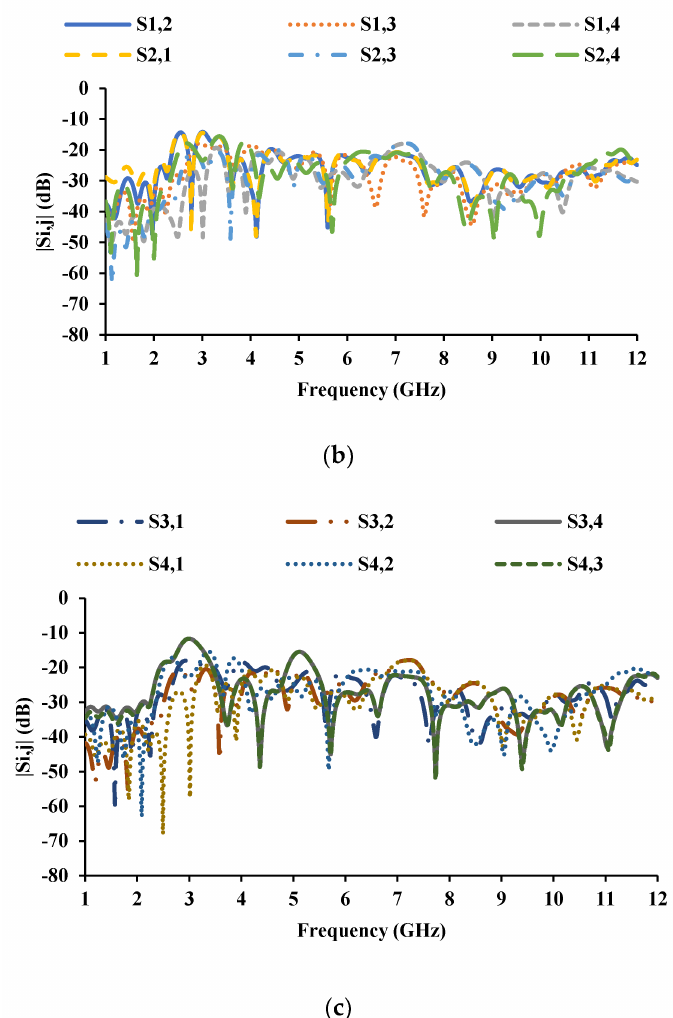
Figure 8. S-parameters of the MIMO antenna with unconnected ground planes: ( a ) reflection coefficients, ( b ) mutual coupling with respect to port 1 and port 2, ( c ) mutual coupling with respect to port 3 and port 4.